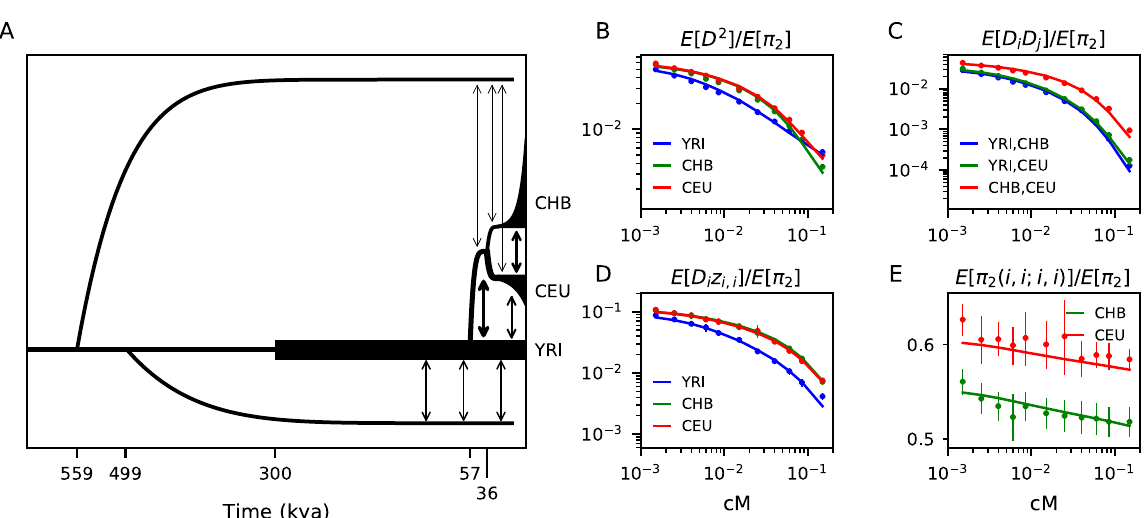
Fig 4. Inferred OOA model with archaic admixture. (A) We fit a model for out-of-Africa expansion related to the standard model in Fig 3A. Demographic events for the three modern human populations are parameterized as above, but we also include two branches with deep split from the ancestral population to modern humans. A putatively Neanderthal branch that remains isolated until the Eurasian split from YRI, and a deep branch within Africa that is allowed to be isolated for some time before continuously exchanging migrants with the common ancestral branch and the YRI branch. (B-E) This model fits the data much better than the model without archaic admixture, and especially for the Dz statistics (D). Fits to 35 more curves and statistics are shown in Fig A7 in S1 Appendix, and residuals are shown in Fig A8 in S1 Appendix. The migration rates inferred between the diverged African branch and YRI provides an estimate of * 7.5% contribution.